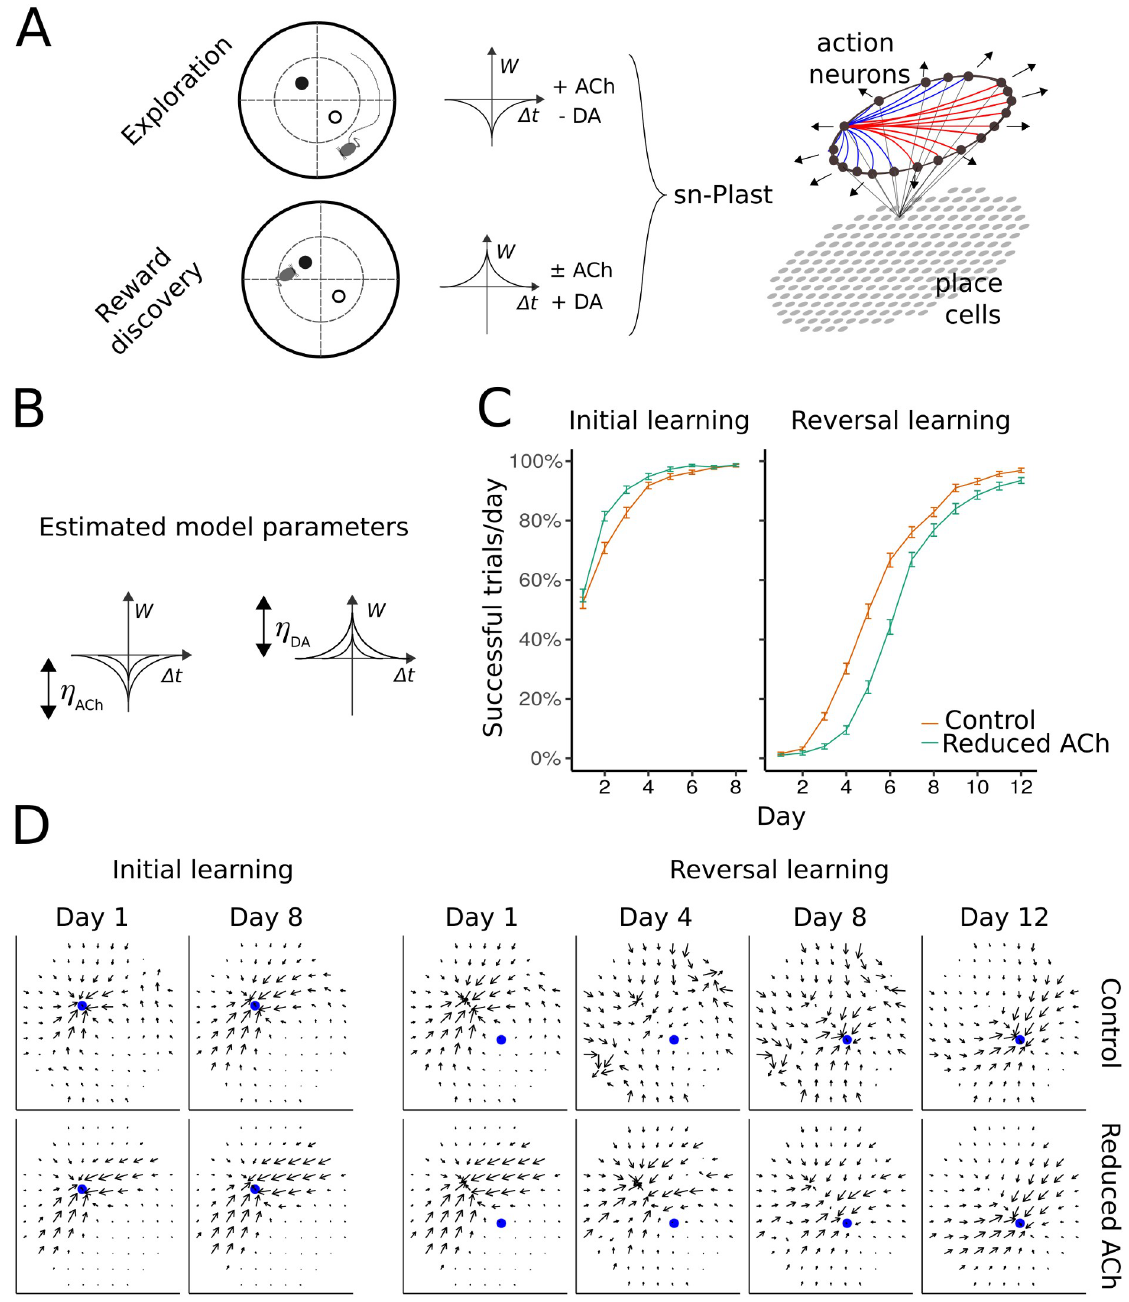
Fig 2. Reducing acetylcholine in the sn-Plast model qualitatively accounts for the behavioural data. (A) The sn-Plast learning rule governing synaptic weight changes in the model. STDP changes synaptic weights ( W ) as a function of the time difference between pre- and postsynaptic spikes ( Δ t ). The STDP windows are symmetric, and the sign of the weight change is determined by the neuromodulator. Acetylcholine is present during exploration, biasing STDP towards synaptic depression. When a reward is encountered, a phasic dopaminergic signal is released, which potentiates active synapses through an eligibility trace. The model consists of a one-layer network of place cells, representing the agent’s position, projecting to a ring network of recurrently connected action neurons coding for the direction taken by the agent. Connections between action neurons with similar tuning are excitatory (blue), but are inhibitory otherwise (red). The weights between place cells and action cells are modified according to the sn-Plast learning rule. (B) Learning rate parameters which control the STDP window amplitude. (C) Reducing acetylcholine in the model ( η ACh = 0.000345 to η ACh = 0.000184, at η DA = 0.00115) impairs reversal learning, reproducing learning curves similar to group performance of control and light-on mice as shown in Fig 1B. (D) Policy preference map at different stages of the task for parameters used in C. Blue filled circle indicates the location of the reward in the open